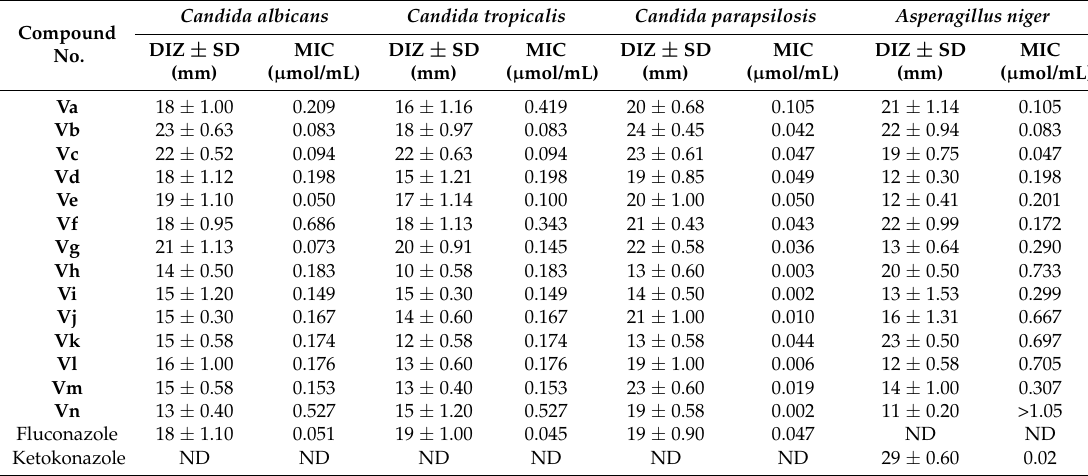
Table 3. Antifungal activity of the target oximino ethers Va – n against C. albicans , C. tropicalis , C. parapsilosis and A.